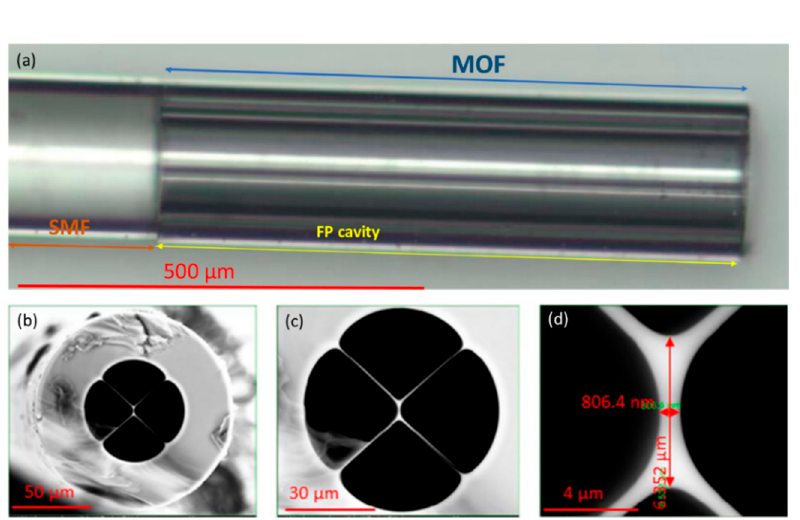
Figure 19. (a) SSC based on Fabry–Perot interferometer; (b) its cross-section and; (c) the four-bridge MOF core with (d) details of its geometry. Reprinted with permission from [123]. MOF core with ( d ) details of its geometry. Reprinted with permission from